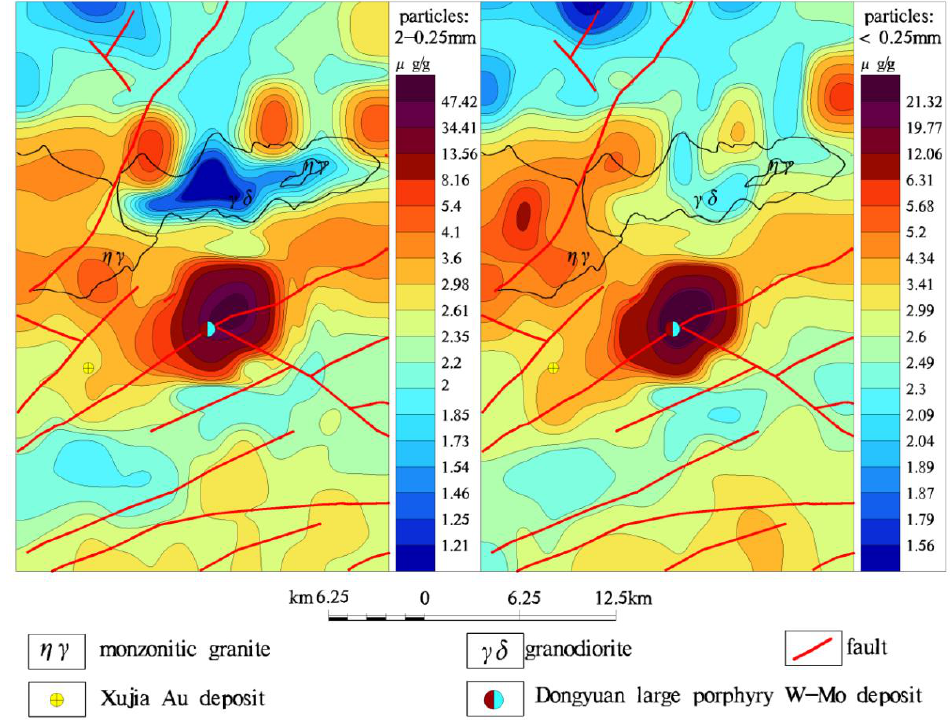
Figure 9. Geochemical maps of W in 0.25–2 mm and <0.25 mm fraction of stream sediments in the pilot area.